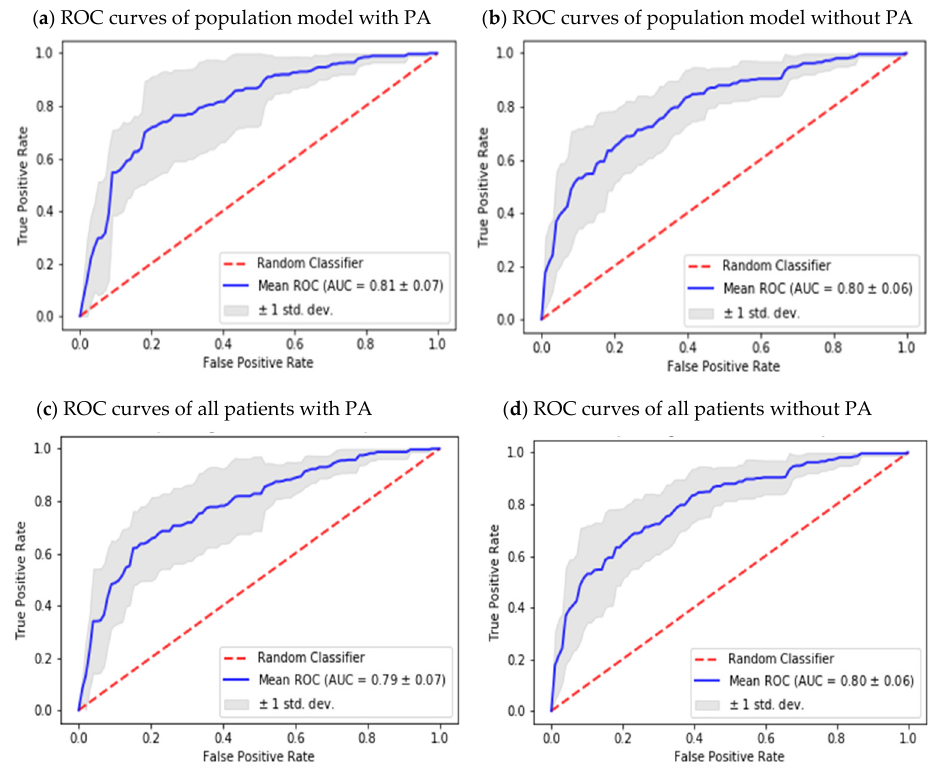
Figure 4. ( a , b ) represent the receiver operating characteristic (ROC) curves generated by population models, both including (left) and excluding (right) PA models. Figures ( c , d ) represent the ROC curves generated by population models per patient, both including (left) and excluding (right) PA models.